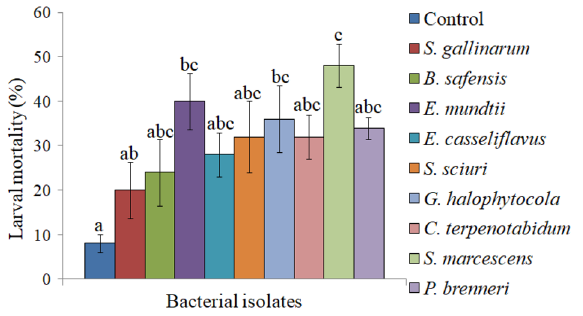
Figure 1. Pathogenicity of bacterial isolates of S. litura against its second-instar larvae at 1.8 × 10 9 cfu/ml (approx). Columns and bars represent the mean ± SE. Different letters above the columns representing each bacteria indicate significant differences at Tukey’s test p ≤ 0.05.